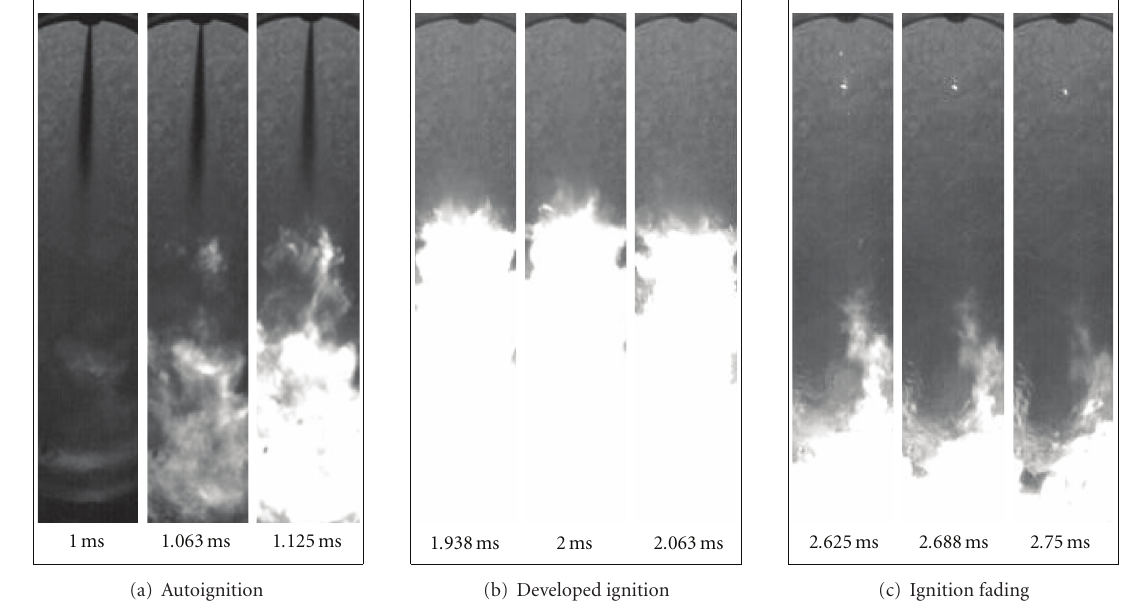
Figure 19: Image sets taken from di ff erent ignition sequences of the diesel fuel with Nozzle C (3.5MPa ambient pressure, 828K ambient temperature, 50 MPa injection pressure, 1.5ms injection duration).